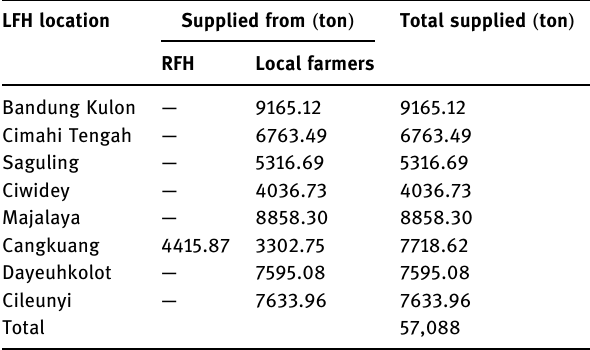
Table 1: Rice supply from local farmers and regional food hub ( RFH ) to local food hubs ( LFHs